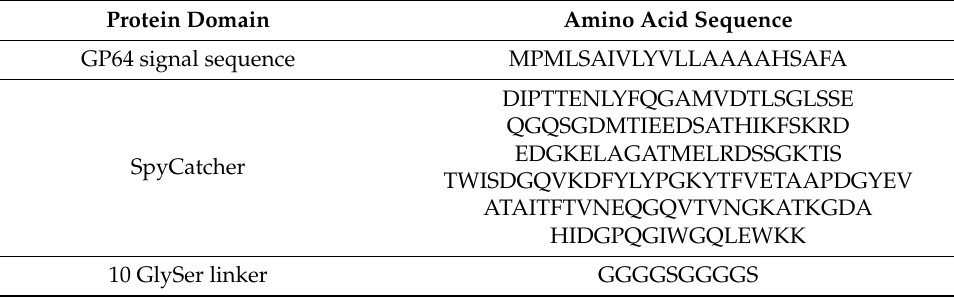
Table 1. Amino acid sequences of antigens, MPSPs, superglue domains and